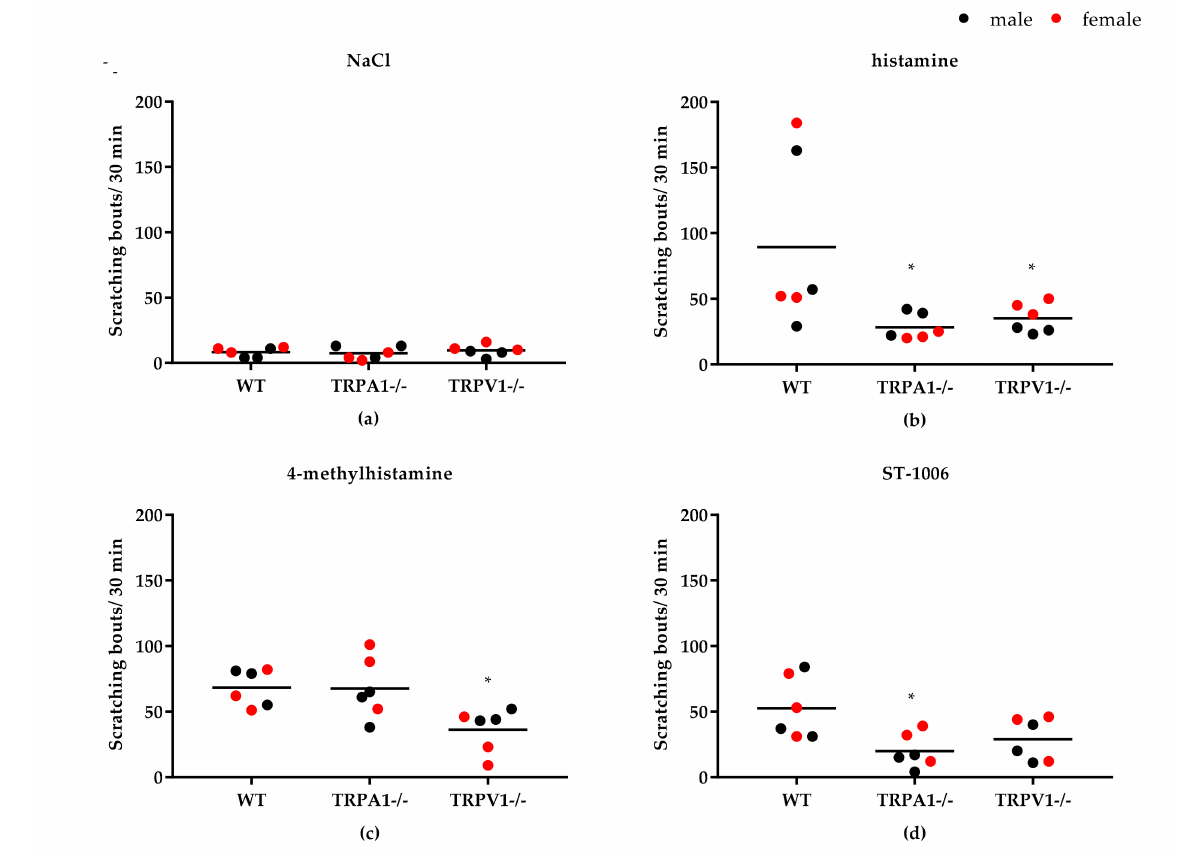
Figure 5. Histamine-induced itch in TRPV1 − / − and TRPA − / − mice compared to wild type mice (C57BL/6; WT). ( a ) No significant scratching response after 0.9% NaCl (vehicle control) injection (50 µ L, i.d.) in all three mouse strains. ( b ) Both TRPV1 − / − and TRPA − / − mice showed a significantly lower scratching response to histamine (all HR) injection (800 nmol/L, i.d.) compared to wild type mice. ( c ) TRPV1 − / − showed a significantly lower response to 4-MH (H2R/H4R) injection (500 nmol/L, i.d.) compared to wild type mice. ( d ) TRPA − / − mice showed a significantly lower scratching response to ST-1006 (H4R) injection (100 nmol/L, i.d.). Observation time: 30 min. Results displayed as scatter-dot plots with median. n = 6 per group ( n = 3 per sex). * p < 0.05 (Mann–Whitney U test) = significantly different from wild